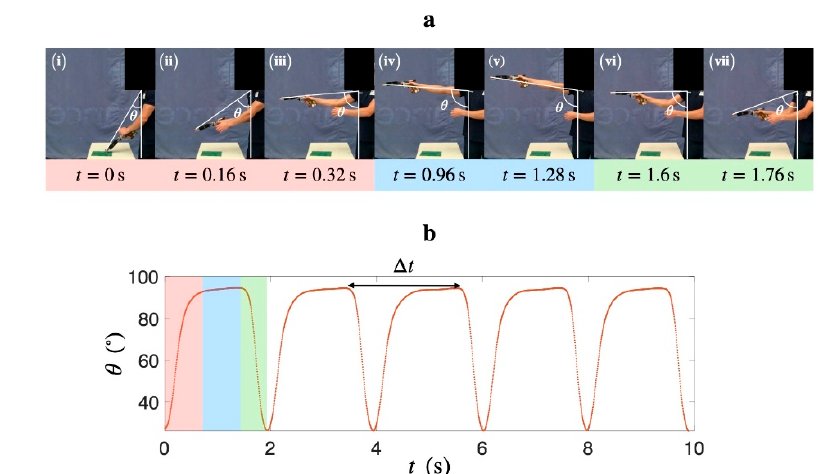
Figure 1. Shooting motion in modern pentathlon. ( a ) Snapshots of the raising phase of one movement. We note 𝜃 the angle of the arm with the vertical. ( b ) Time evolution of the arm’s angle of one series of 5 shots. The shot time is noted Δ 𝑡 and is here imposed at 2.0 s. The colored regions materialize the three phases of the shooting motion: the rising of the arm (red), the aiming (blue) and the lowering of the arm